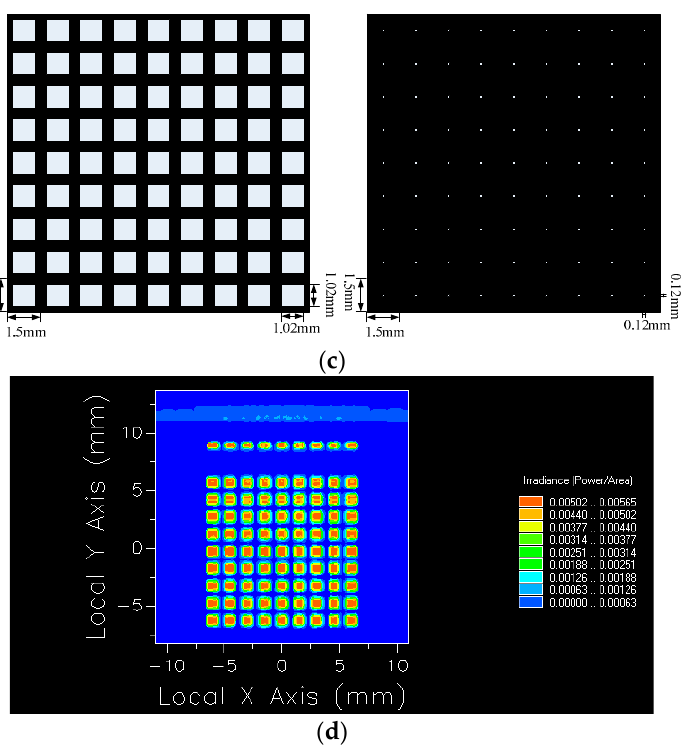
Figure 9. Imaging diagram with crosstalk suppression stop arrays (Y axis, δ = − 2 ◦ , θ = − 0.5 ◦ ). ( a ) Schematic of non-crosstalk beams in the system, ( b ) Partial enlargement of system, ( c ) Structure diagram of crosstalk suppression stop arrays ( left ): stop array 1, ( right ): stop array 2), ( d ) Image power distribution on the plane. Table 3. Power value (Watts) of each aperture (Y axis, δ = − 2°, θ = − 0.5°).